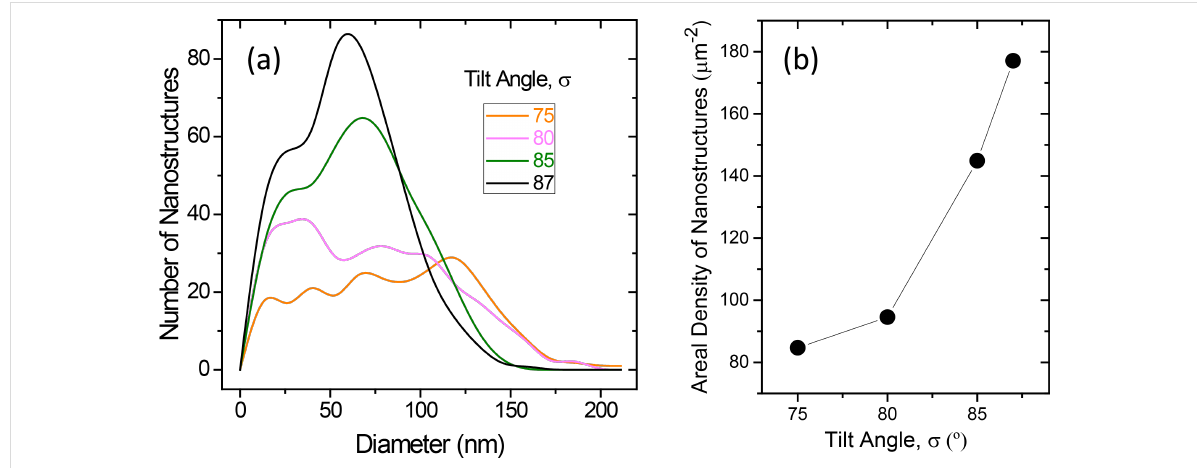
Figure 3: (a) Diameter distribution obtained from top-view SEM images for the Au samples prepared onto Si substrates with different tilt angles. (b) Areal density of nanostructures of the same samples.